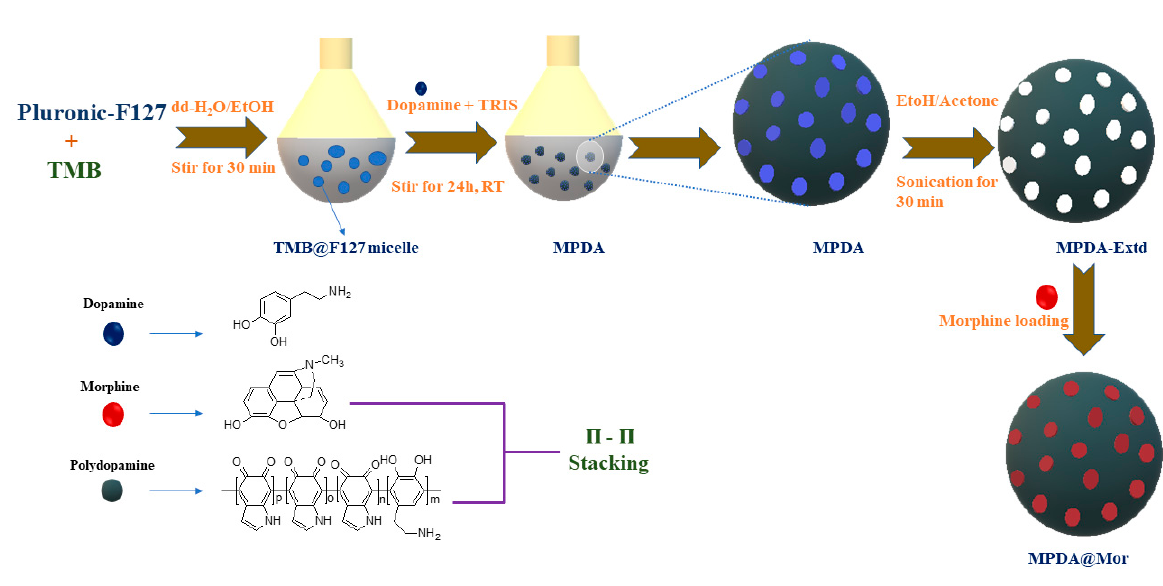
Figure 1. A schematic illustration for the synthesis and drug loading of mesoporous polydopamine (MPDA), and morphine drug loading in to MPDA nano-antioxidants.